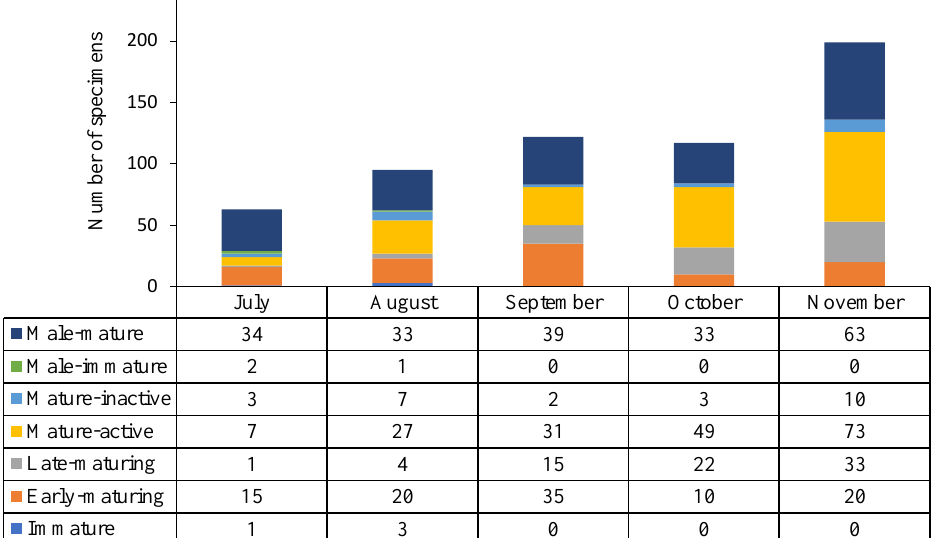
1 Female : P = 1 + exp − 0.128 ∗ ( FL i − 84 ) 1 Male : P = 1 + exp − 0.129 ∗ ( FL i − 83 )